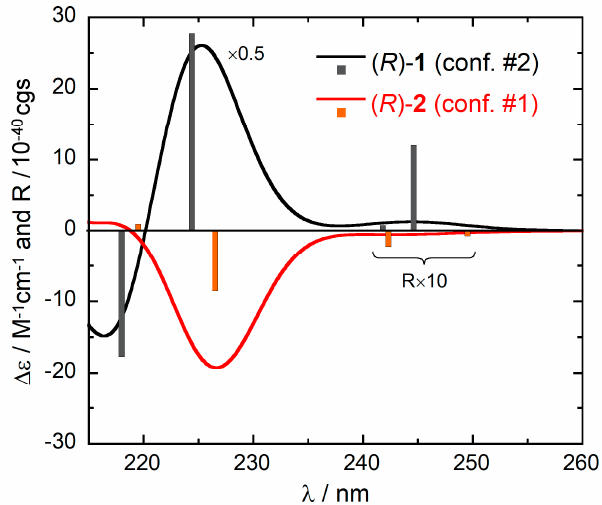
Figure 6. Comparison between the and calculated ECD spectra of ( R )- 1 (conformer #2) and ( R )- 2 (conformer #1). Plotting parameters as in Figure 2. The vertical bars represent the calculated rotational strengths R, in 10 − 40 cgs units (scaled by a factor 2.5 to fit the vertical axis).